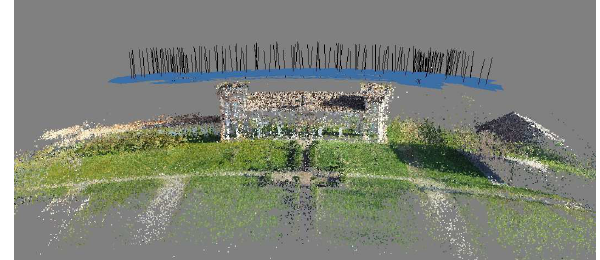
Figure 4: bowl-effect visible on first alignment